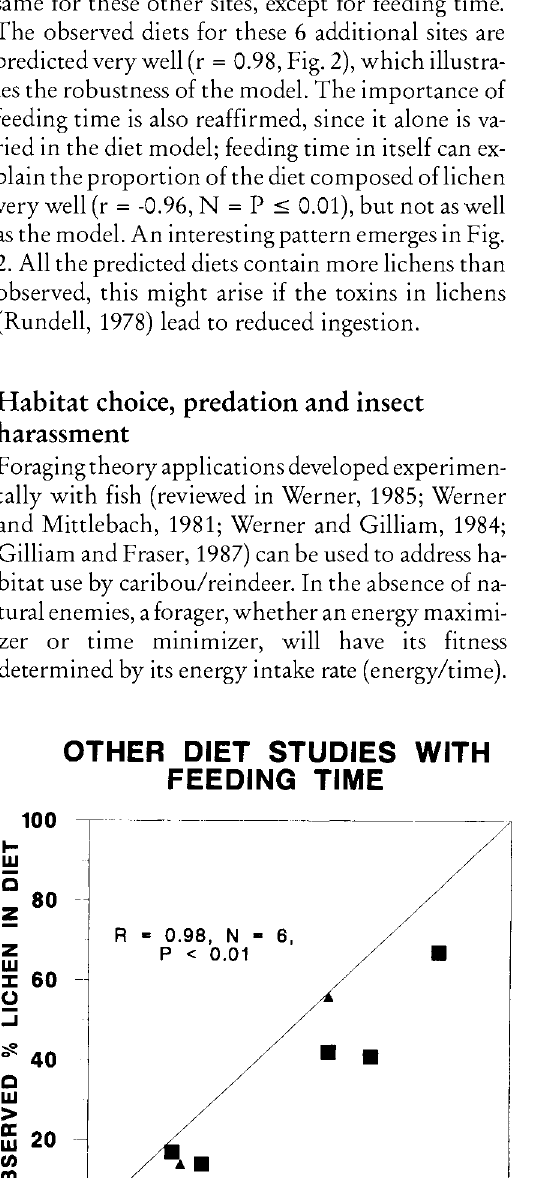
Fig. 2. The comparison of the predicted and observed proportion of the caribou/ reindeer diet composed of lichens for 6 studies (squares: Wright, 1980; Skogland, 1984; Martell et al, 1985, White et al, 1975) is presented. The studies used to develop the linear programming diet model are also presented (triangles: White and Trudell, 1980 a,